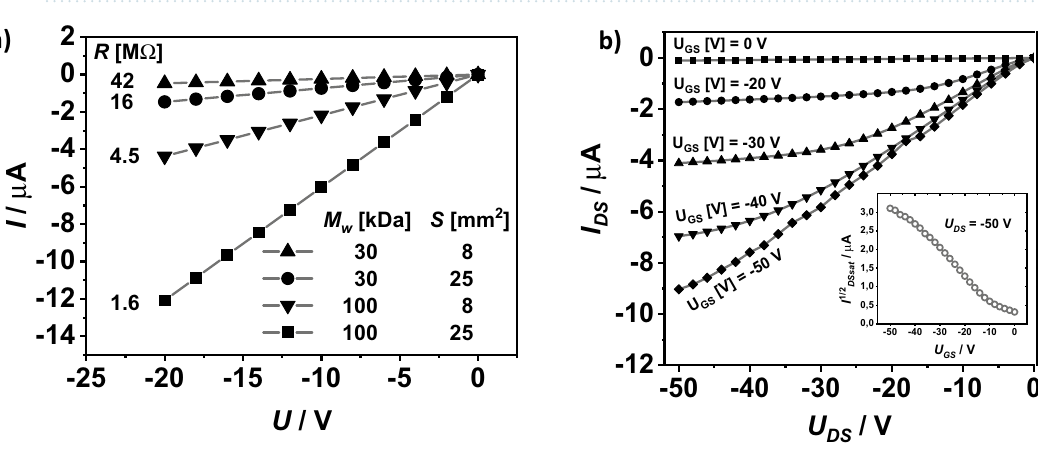
Figure 4. Electrical current–voltage output characteristic of the printed resistors ( a ), and characteristic of the printed transistor (the inset shows the dependence of the square root of the drain current on a gate-drain voltage) ( b